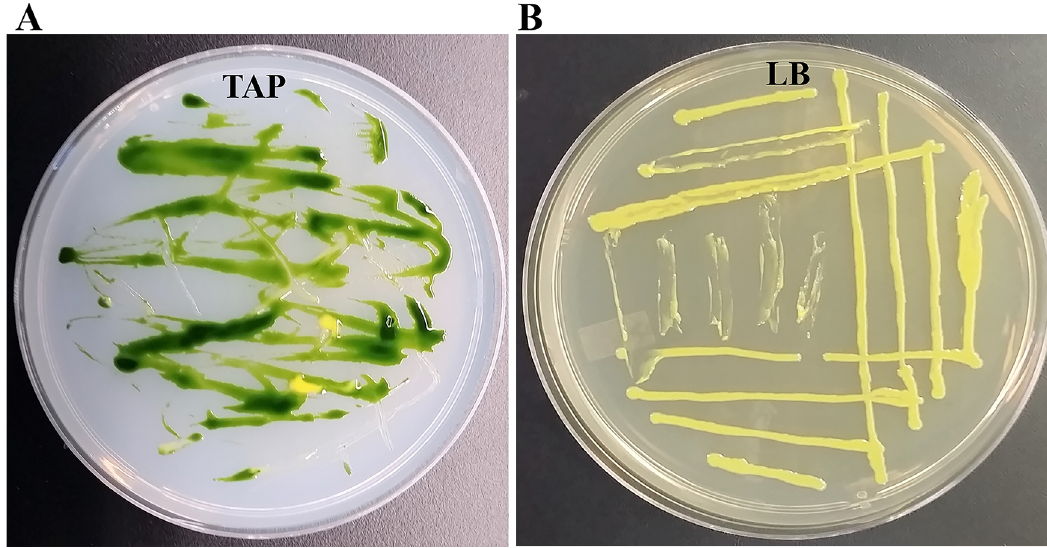
Figure1.IsolationofthebacterialstrainClip185fromacontaminated Chlamydomonas TAP-agarplate. (A)Tris- Acetate-Phosphate (TAP)-agar medium plate showing bacterial contamination of a Chlamydomonas strain at room